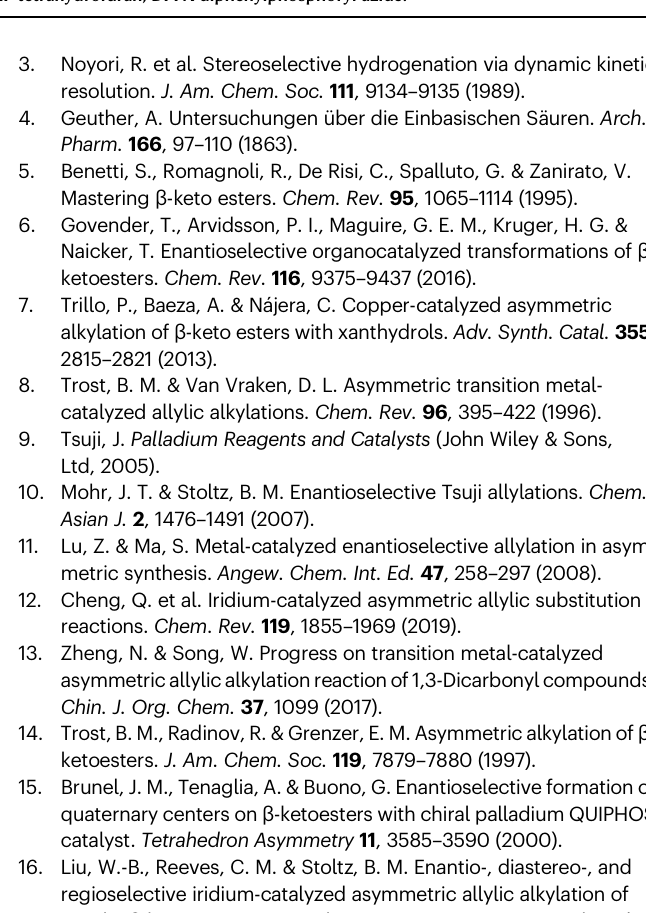
Fig. 5 | Formal synthesis of (+)-pancratistatin. TBHP tert -butyl hydroperoxide, THF tetrahydrofuran, DPPA diphenylphosphoryl